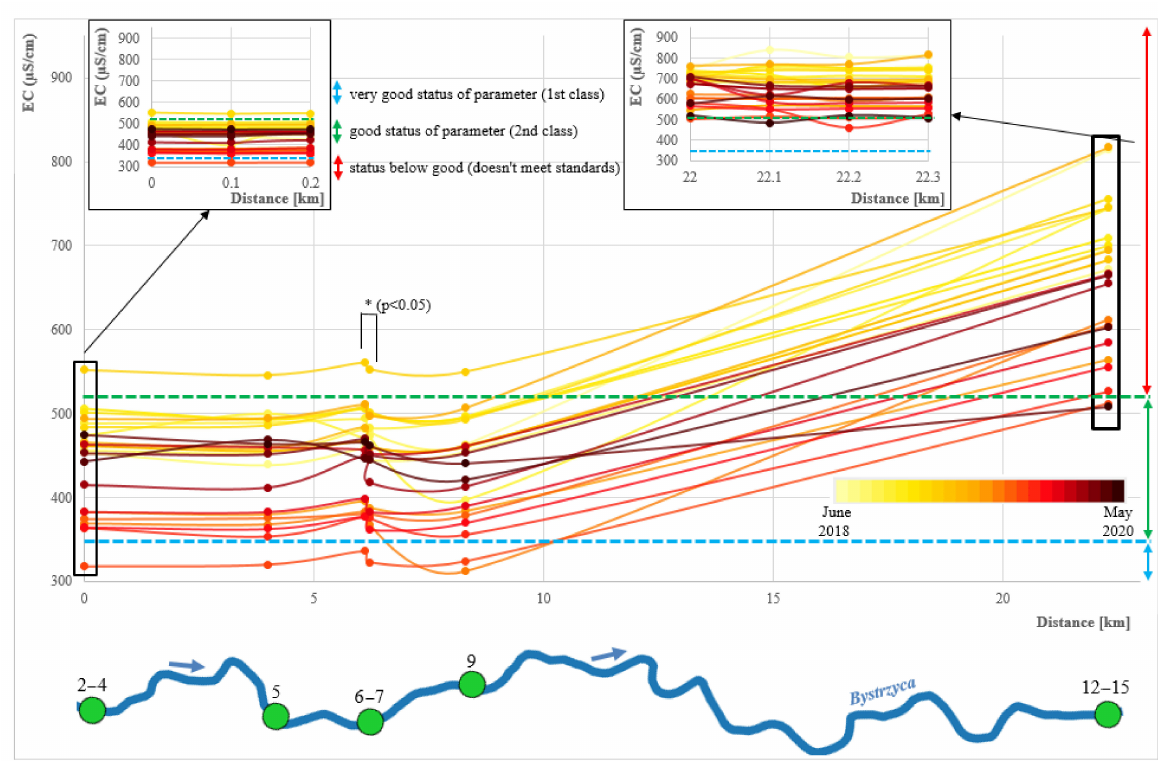
Figure A1. Temporal and spatial variability of EC at the tested measurement points, including the physicochemical condition of the parameter and statistical significance within the Sadowice, Skałka, and Marszowice HPs ( p < 0.05).